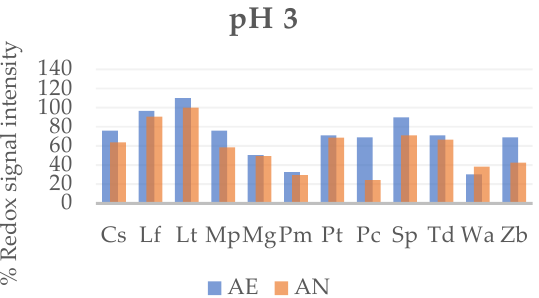
Figure 3. Metabolic output expressed as redox signal intensity of non- Saccharomyces yeast strains at low pH in aerobic (AE) and anaerobic (AN).